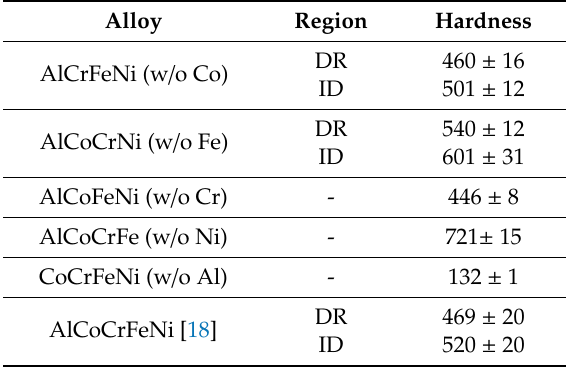
Figure 7. ( a ) BF TEM images of the DR area of the AlCrFeNi (w / o Co) alloy. ( b ) Exhibits an interface between the ID and DR areas. ( c , d ) BF and DF TEM images of the ID area. Corresponding SAED is shown in the inset. It can be seen that the phase with high dislocation density is BCC, since it does not light up on DF image taken with g = (111), shown in ( d ). Table 2. A summary of the micro-hardness values (in HV0.1) of the studied alloys and the quinary AlCoCrFeNi alloy. Microhardness value of the latter was taken from [18].